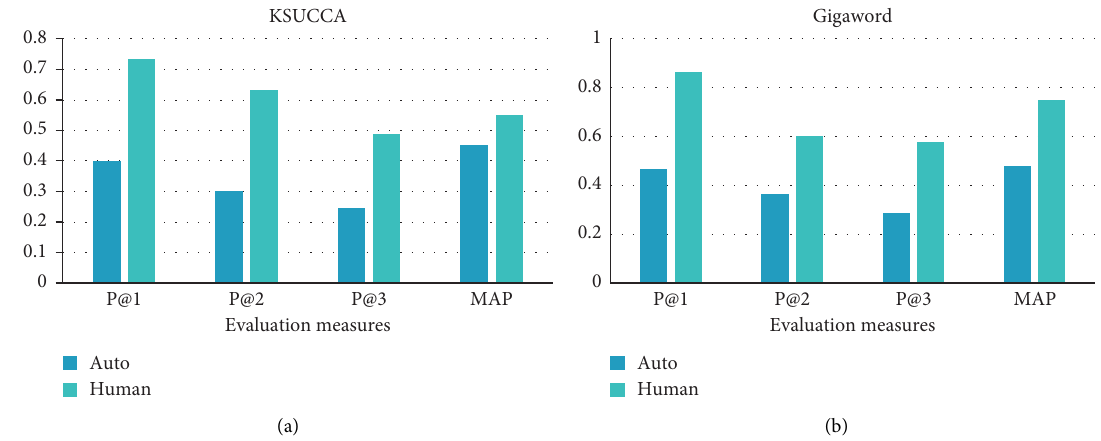
Figure 4: Comparison between the automatic and human evaluations. (a) KSUCCA. (b) Gigaword in terms of P -ranks (1–3) and MAP. Table 17: Sample of the synonyms extracted by the SynoExtractor pipeline along with their RCS values. Seed